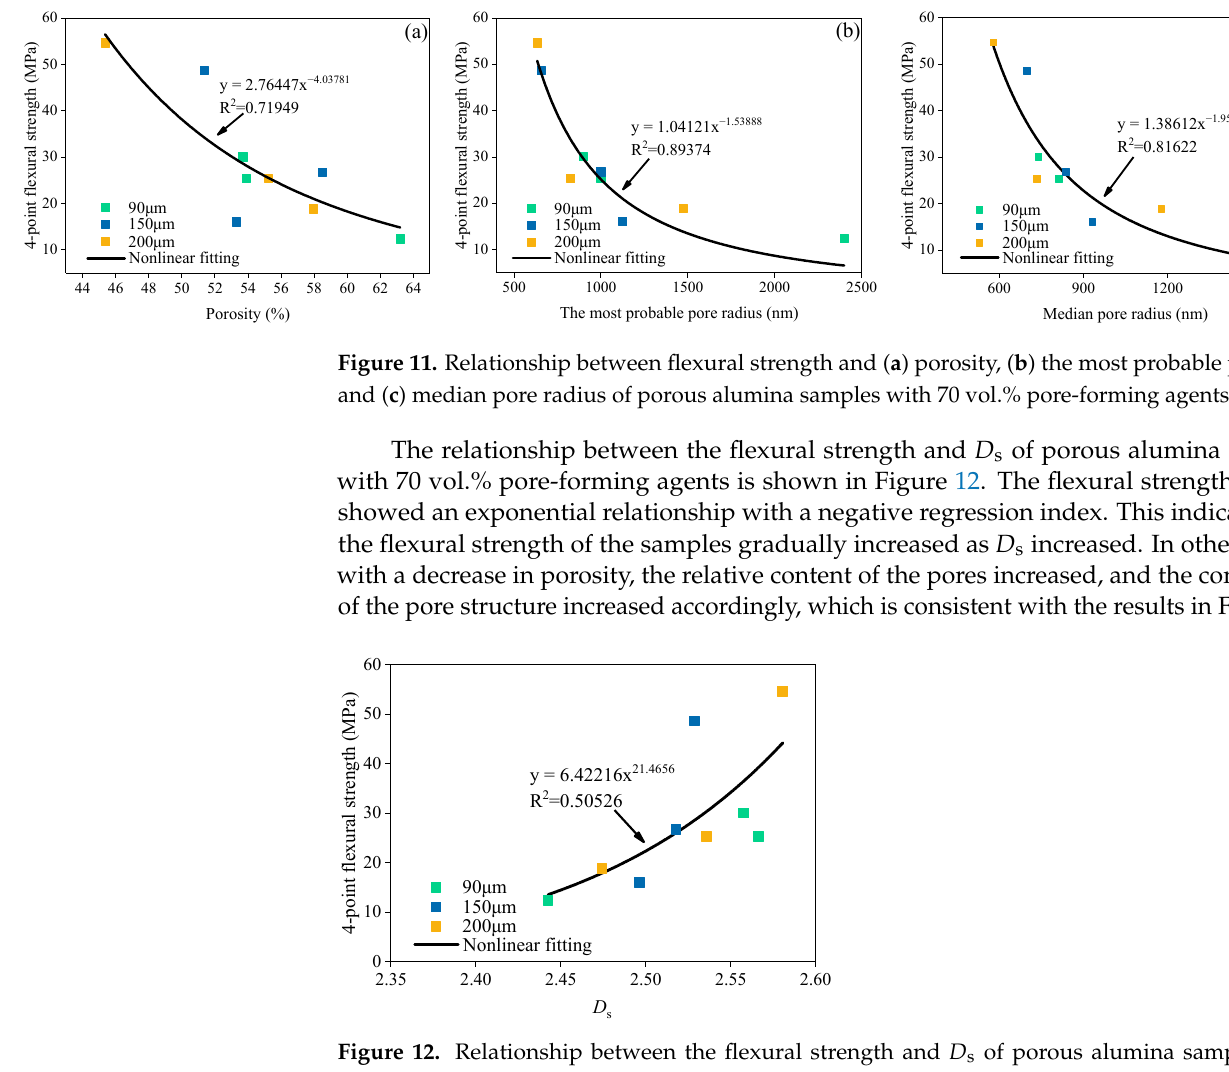
vol.% pore-forming agents. 70